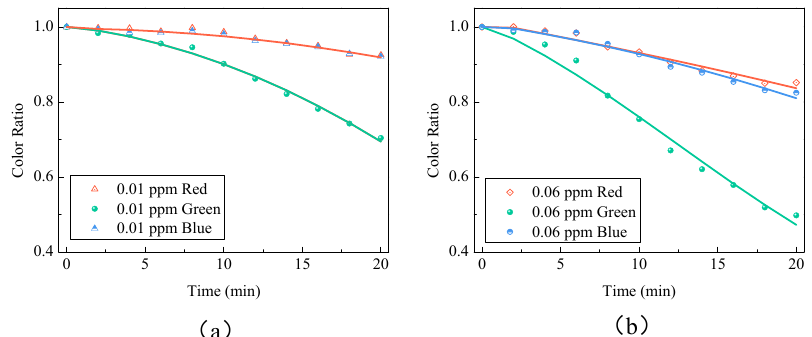
Figure 3. Changes in color ratios of red, green and blue over time in the presence of ( a ) 0.01 ppm and ( b ) 0.06 ppm formaldehyde, respectively.